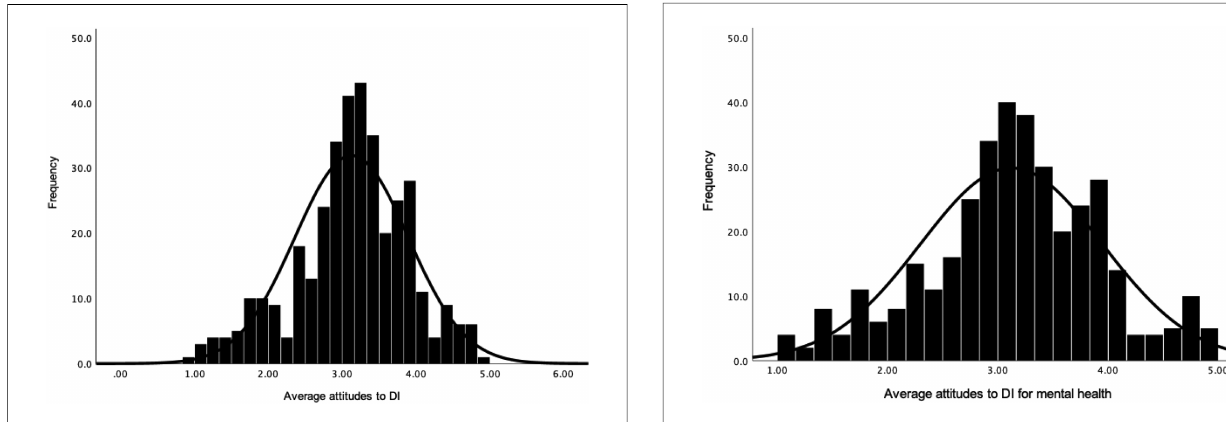
FIGURE 1 Frequency distribution with a normal curve of the average overall attitude towards DI.